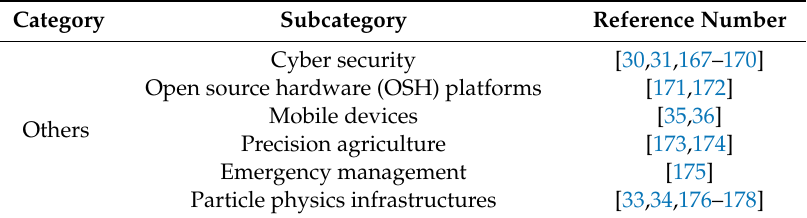
Table 6. Publications in the category of